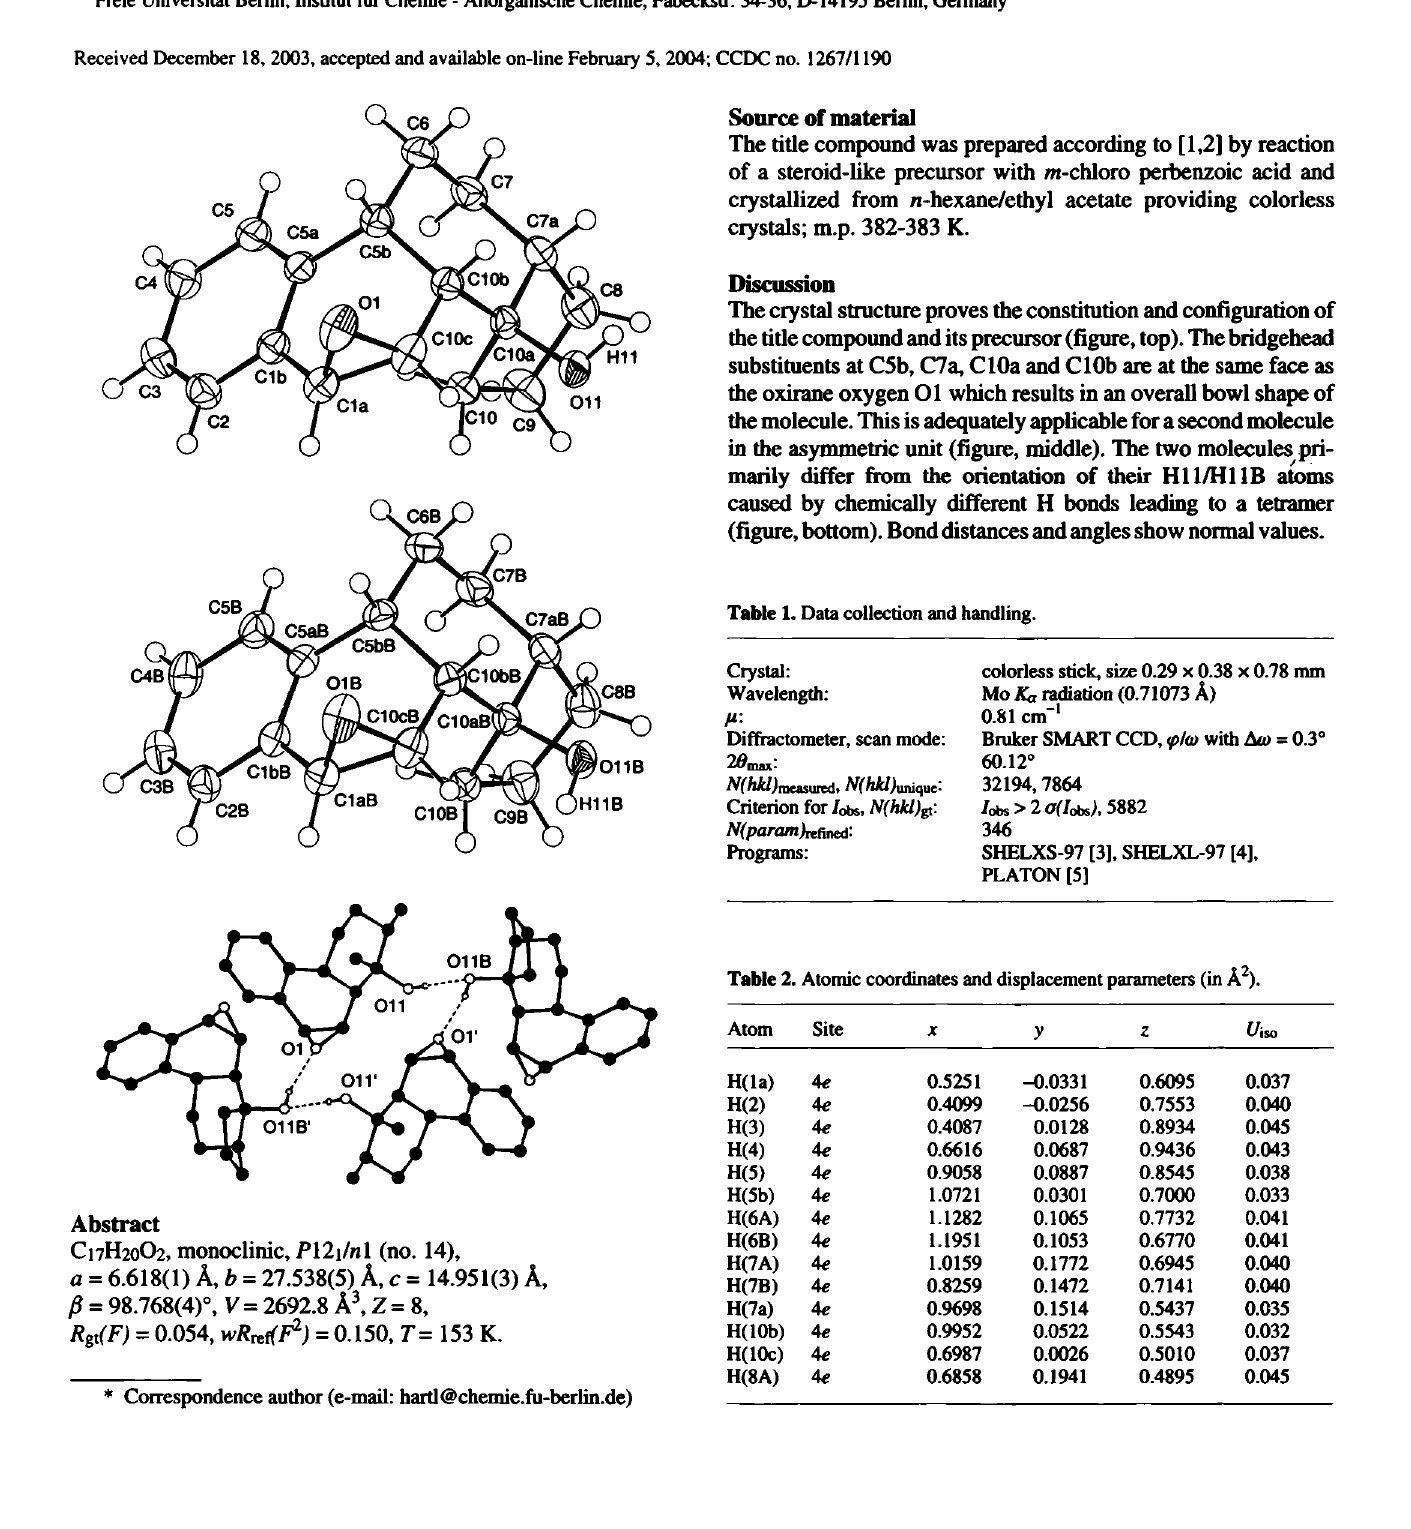
C17H20O2, monoclinic, P12i/«1 (no. 14), a = 6.618(1) Â, b = 27.538(5) Â, c = 14.951(3) Â, ß = 98.768(4)°, V = 2692.8 Â 3 , Z = 8, Rgt(F) = 0.054, wÄreffF 2 ) = 0.150, T= 153 K.